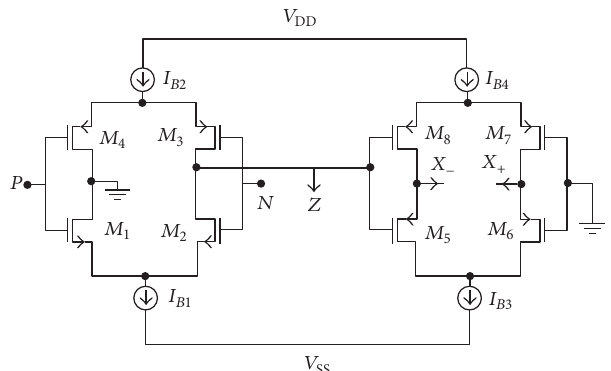
Figure 2: The CMOS realization of VDTA [10].